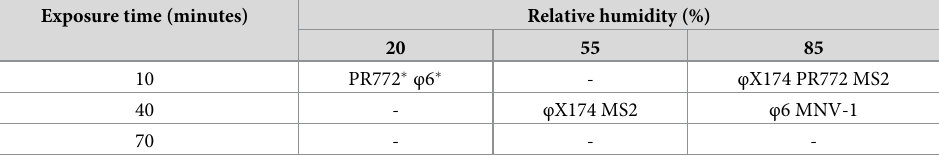
Table 3. Summary of the effect of ozone at 1.13 ppm ± 0.26 ppm on the four tested phages and at 0.23 ppm ± 0.03 ppm on MNV-1 at three levels of relative humidity and three exposure times. Exposure time (minutes)